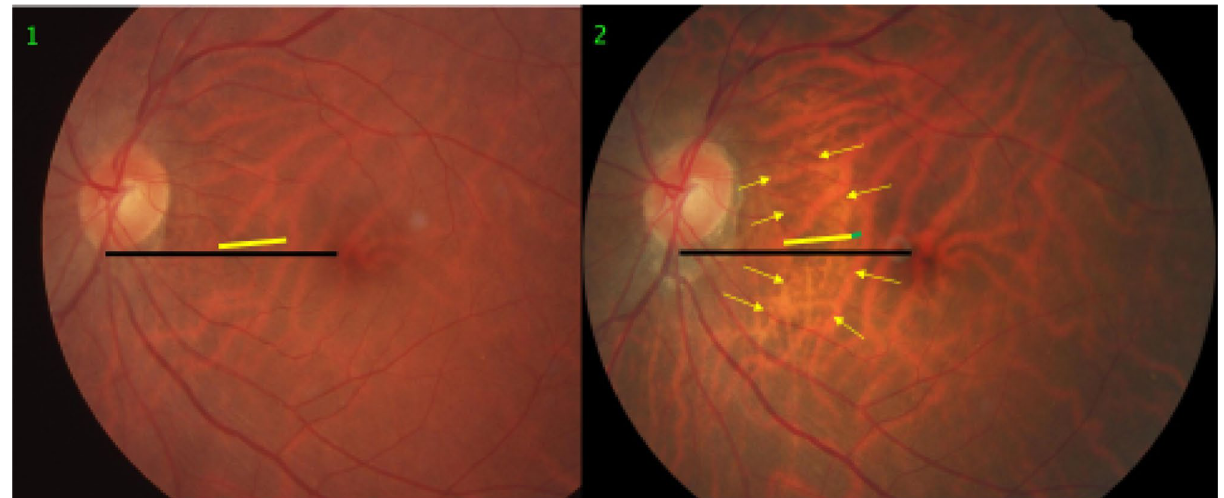
Figure 6. Fundus photographs of a highly myopic eye taken with an interval of 10 years (left image taken in 2001; right image taken in 2011). Note : development of a vertical diffuse chorioretinal atrophy (multiple yellow arrows), parallel to an elongation of the distance between two horizontal choroidal vascular markings, compared between baseline (yellow bar) and follow up (equally long yellow bar plus green bar), suggesting a spreading of the choroidal vessels. Distance between the fovea and the disc border (equally long black bars) constant during follow-up. The choroidal vessel shift occurred perpendicular to the longest diameter of the area with diffuse chorioretinal atrophy.